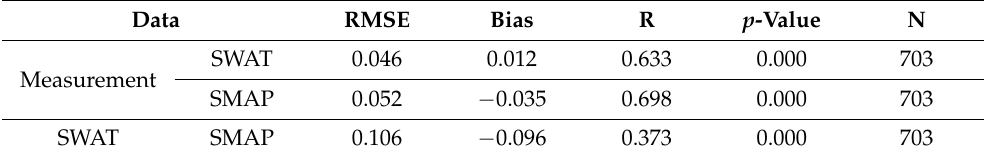
Table 3. Daily calibration of SWAT model with field measurement data and